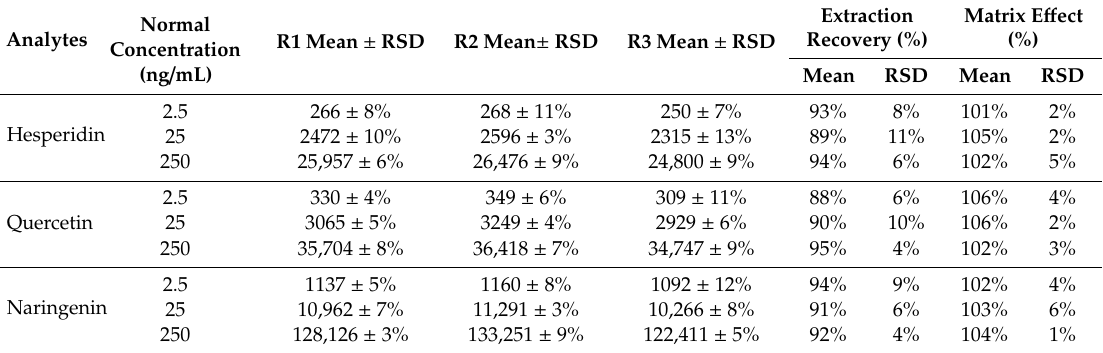
Table 3. Extraction recovery and matrix e ff ect of flavonoids ( n =